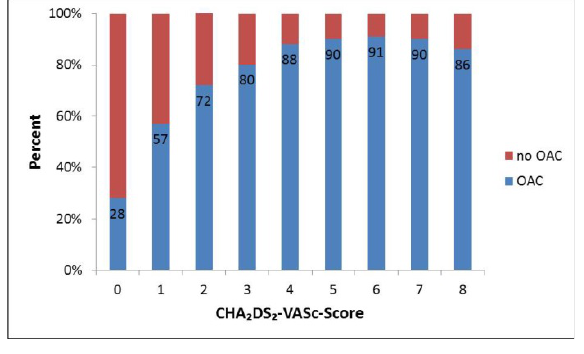
Figure 2: Oral anticoagulation (OAC) according to CHA 2 DS 2 -VASc score at baseline.